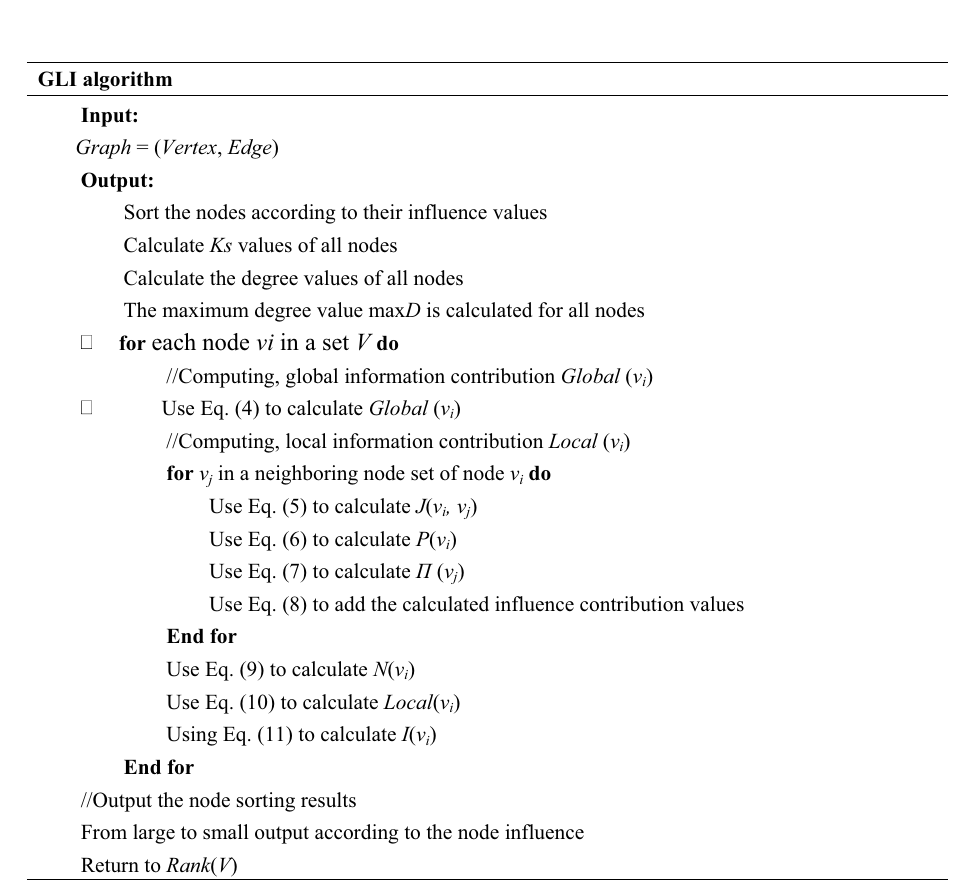
Figure 1. A network diagram, where yellow nodes indicate the sample nodes. The K-shell algorithm is used to divide the network into three layers, and node v 1 is in the third